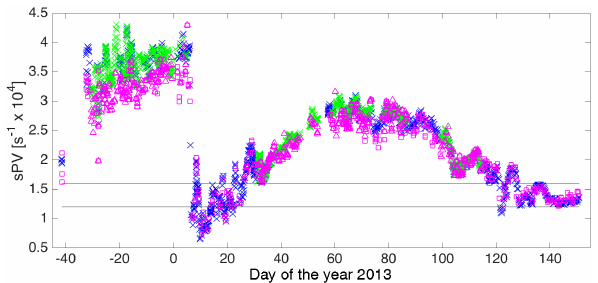
Figure 11. sPV values at 34km at the location and time of all KIMRA measurements (blue X), and coincident MLS measure- ments (magenta square). The same is shown for all MIRA 2 mea- surements (green X) and coincident MLS measurements (magenta triangle). The black lines indicate the edges of the polar vortex (see Fig. 6).